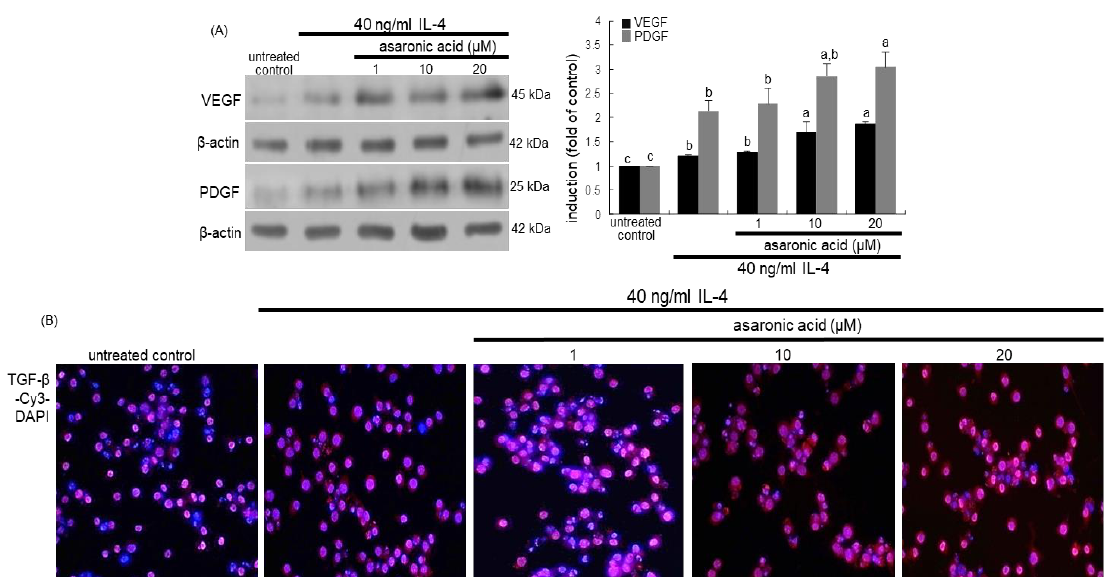
Figure 3. Elevation of induction of PDGF, VEGF, and TGF-β by asaronic acid. J774A.1 macrophages were exposed to 40 ng/mL IL-4 in the absence and presence of 1–20 μM asaronic acid for 48 h. Cell lysates were subject to 8–12% SDS-PAGE and Western blot analysis with a primary antibody against PDGF and VEGF ( A ). β-Actin antibody was used as an internal control. The bar graphs (mean ± SEM, n = 3) in the panels represent quantitative results of the left blot bands obtained from a densitometer. Mean values in respective bar graphs not sharing a same lower-case alphabet letter are significantly different at p < 0.05. Immunocytochemical analysis showing TGF-β induction of IL-4-treated macrophages ( B ). The TGF-β localization was confirmed by Cy3-red staining in macrophages exposed to IL-4 (n=3). Nuclear staining was done with DAPI (blue). Magnification: 200-fold.